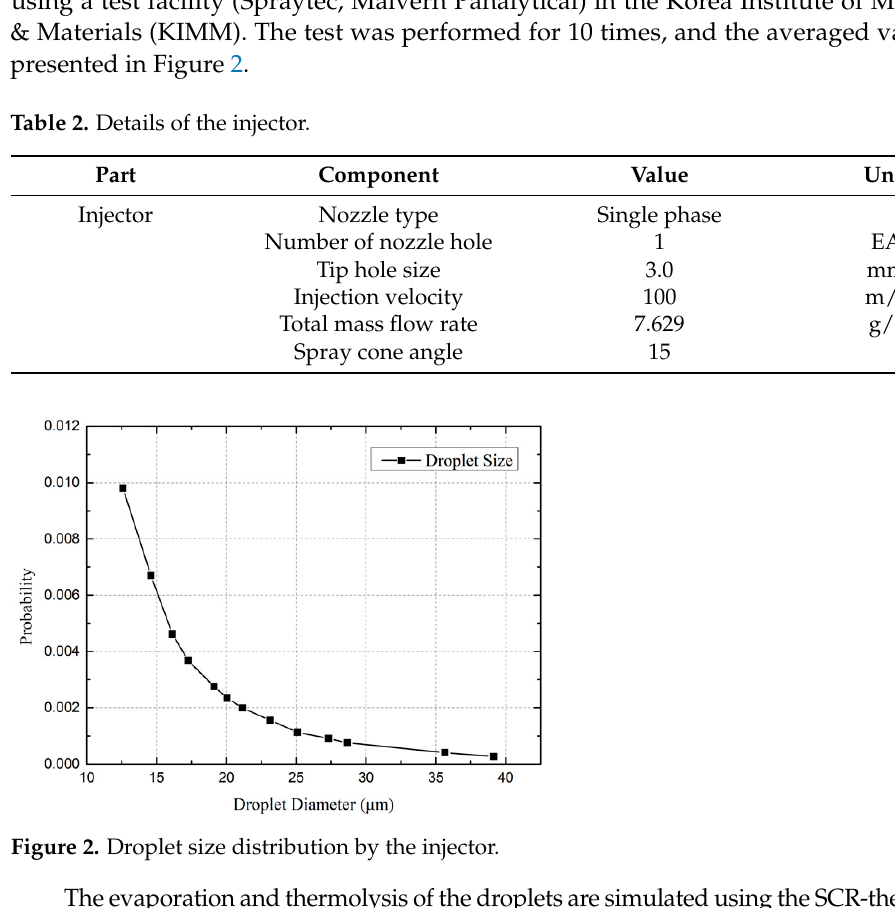
4 of 12 2.2. Urea-SCR Reaction Mechanism In the urea-SCR system, issued droplets are first evaporated, and then converted to NH 3 and iso-cyanic acid (HNCO) via thermolysis in the front of the catalyst layer. The produced HNCO is then changed to NH 3 and CO 2 through an exhaust gas pipe by hy- drolysis reaction. The generated NH 3 is adsorbed by the substrate of the catalyst and can decrease NOx in exhaust gases [14]. To describe the injection and atomization of the urea aqueous solution, the Spay